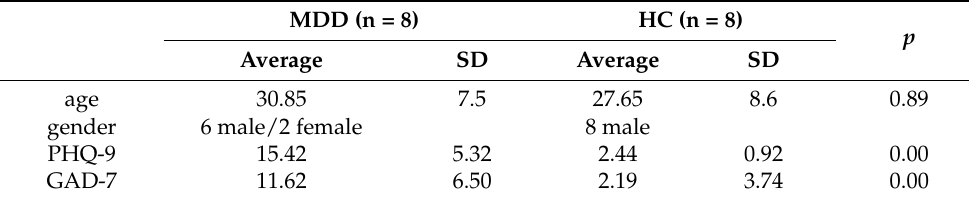
Table 1. Demographic variables of depression patients and healthy